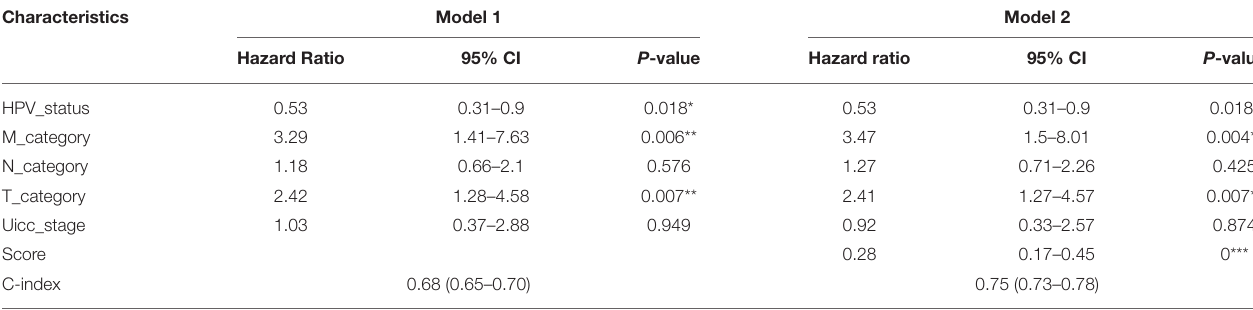
TABLE 3 | Model discussion for 8 lncRNA